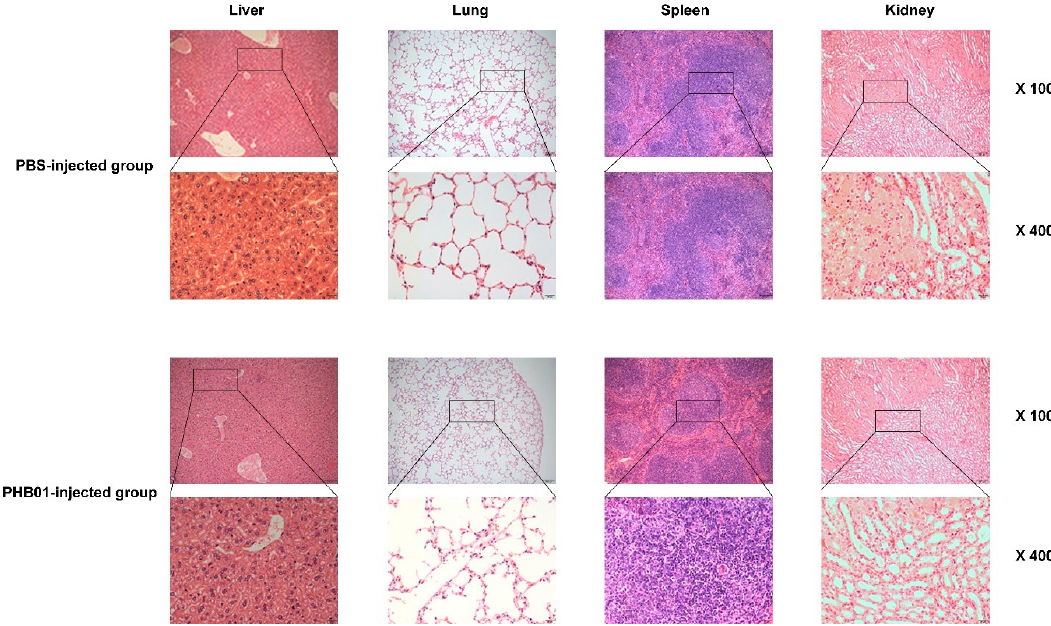
Figure 7. Histopathological analysis of the main organs collected from the mice received a challenge of phage PHB01 and/or PBS. The liver, spleen, kidney, and lungs were fixed with 4% formalin. Tissue sections were stained with hematoxylin and eosin or toluidine blue.